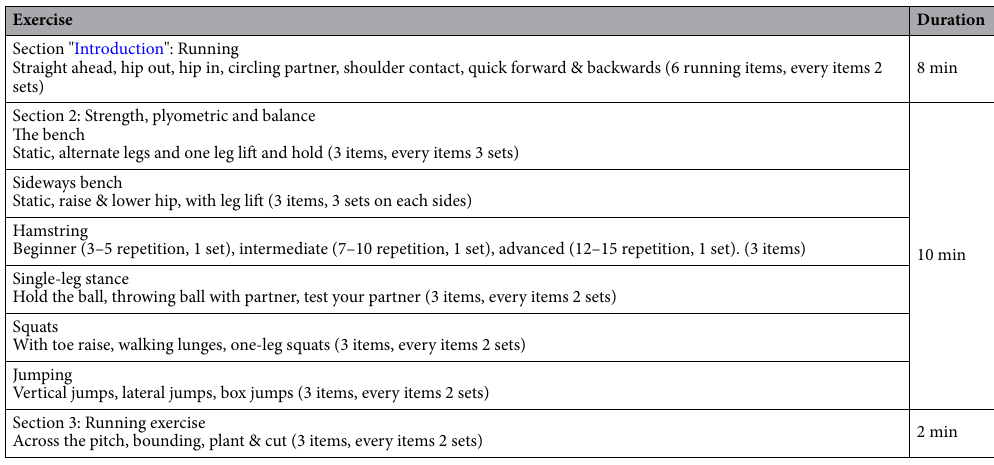
Table 4. The ‘‘11 + ’’. Exercises, duration and intensities of the structured warm-up program used